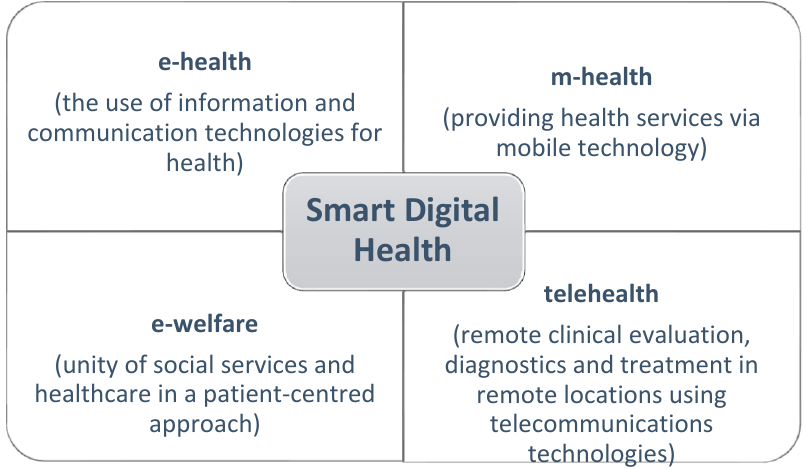
Figure 8. Socio-technical model for the management and provision of healthcare [42].